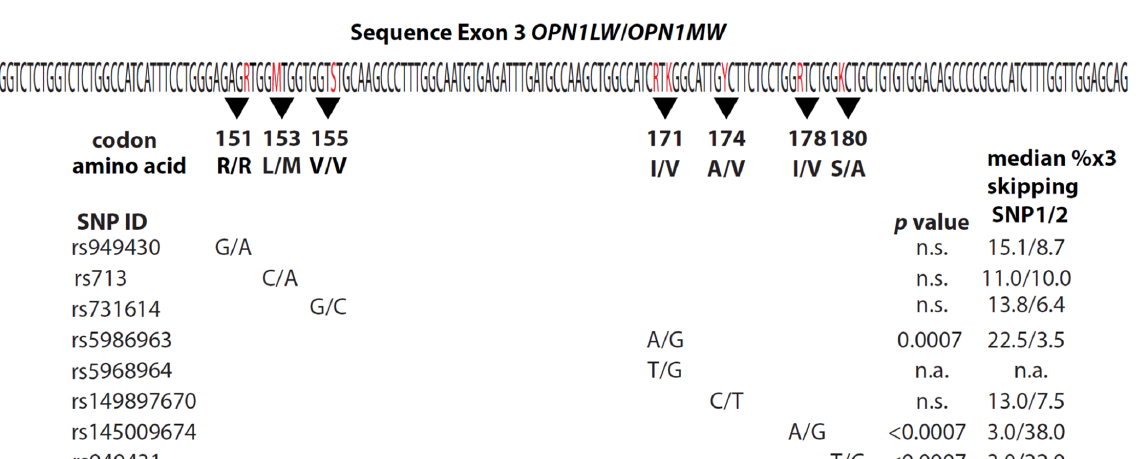
the probability of this occurring by chance is 4.51 × 10 − 9 . Haplotype rank can be used as a measure of the relative risk an individual has for becoming myopic. Thus, the degree of association, as indicated by calculating the Pearson’s correlation coefficient, between SER and haplotype rank for individual subjects is a gauge for the amount of variance in myo- pia attributable to the OPN1LW haplotypes; the coefficient of determination for this asso- ciation is 0.046, indicating polymorphisms in OPN1LW account for about 4.6% of the var- iance in common myopia. We could only analyze the 11 OPN1LW haplotypes found in at least four subjects, which reduced our sample size. However, lower-frequency OPN1LW haplotypes and OPN1MW haplotypes are likely to contribute to myopia through a similar mechanism. For example, in our sample, males with OPN1MW genes encoding only MVVVA ( n = 64)